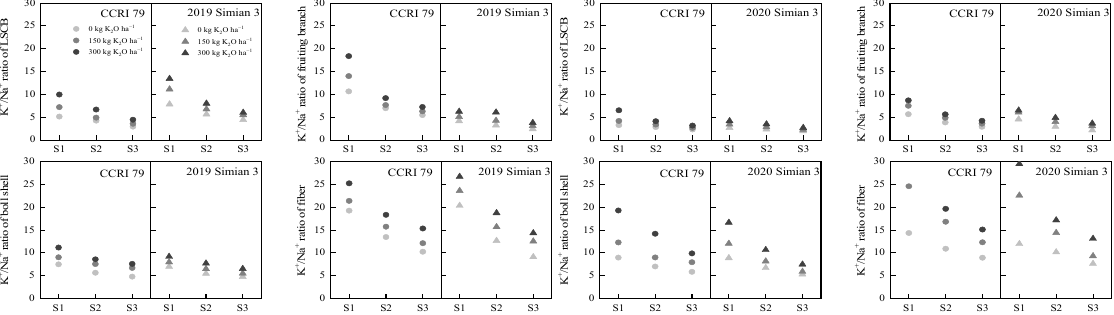
Figure 4. Effect of K application on the K + /Na + ratio in the boll-leaf system at 15 DPA under salt stress. S1, low salinity level; S2, moderate salinity level; S3, high salinity level. In conclusion, salt stress significantly reduced the K + content, increased the Na + content, and decreased the K + /Na + ratio in the boll-leaf system of both cultivars. The K +